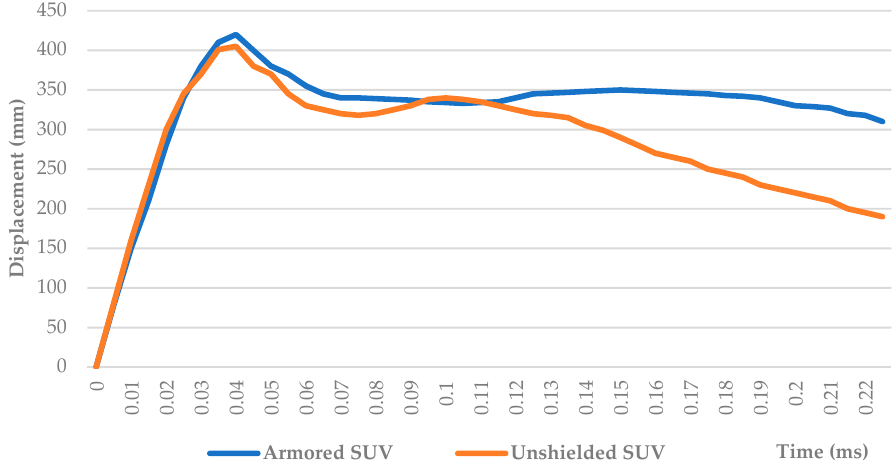
Figure 13. Displacement of the frontal part of the unshielded SUV vs. the armored SUV.